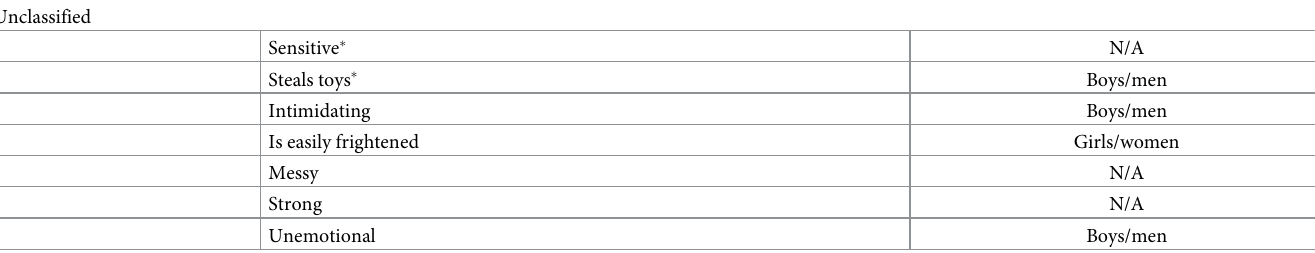
clustering. Due to the subjective and qualitative nature of this classification process, the result- ing clusters should be interpreted as useful ways of digesting our otherwise exceptionally dense dataset, and as helpful jumping-off points for future research. Fig 1 defines and depicts each cluster. Every characteristic and its cluster are depicted in Tables 6 (for ratings of typicality) and 7 (ratings of desirability). Table 7. Characteristics for which gender differences in ratings of desirability interacted with age.